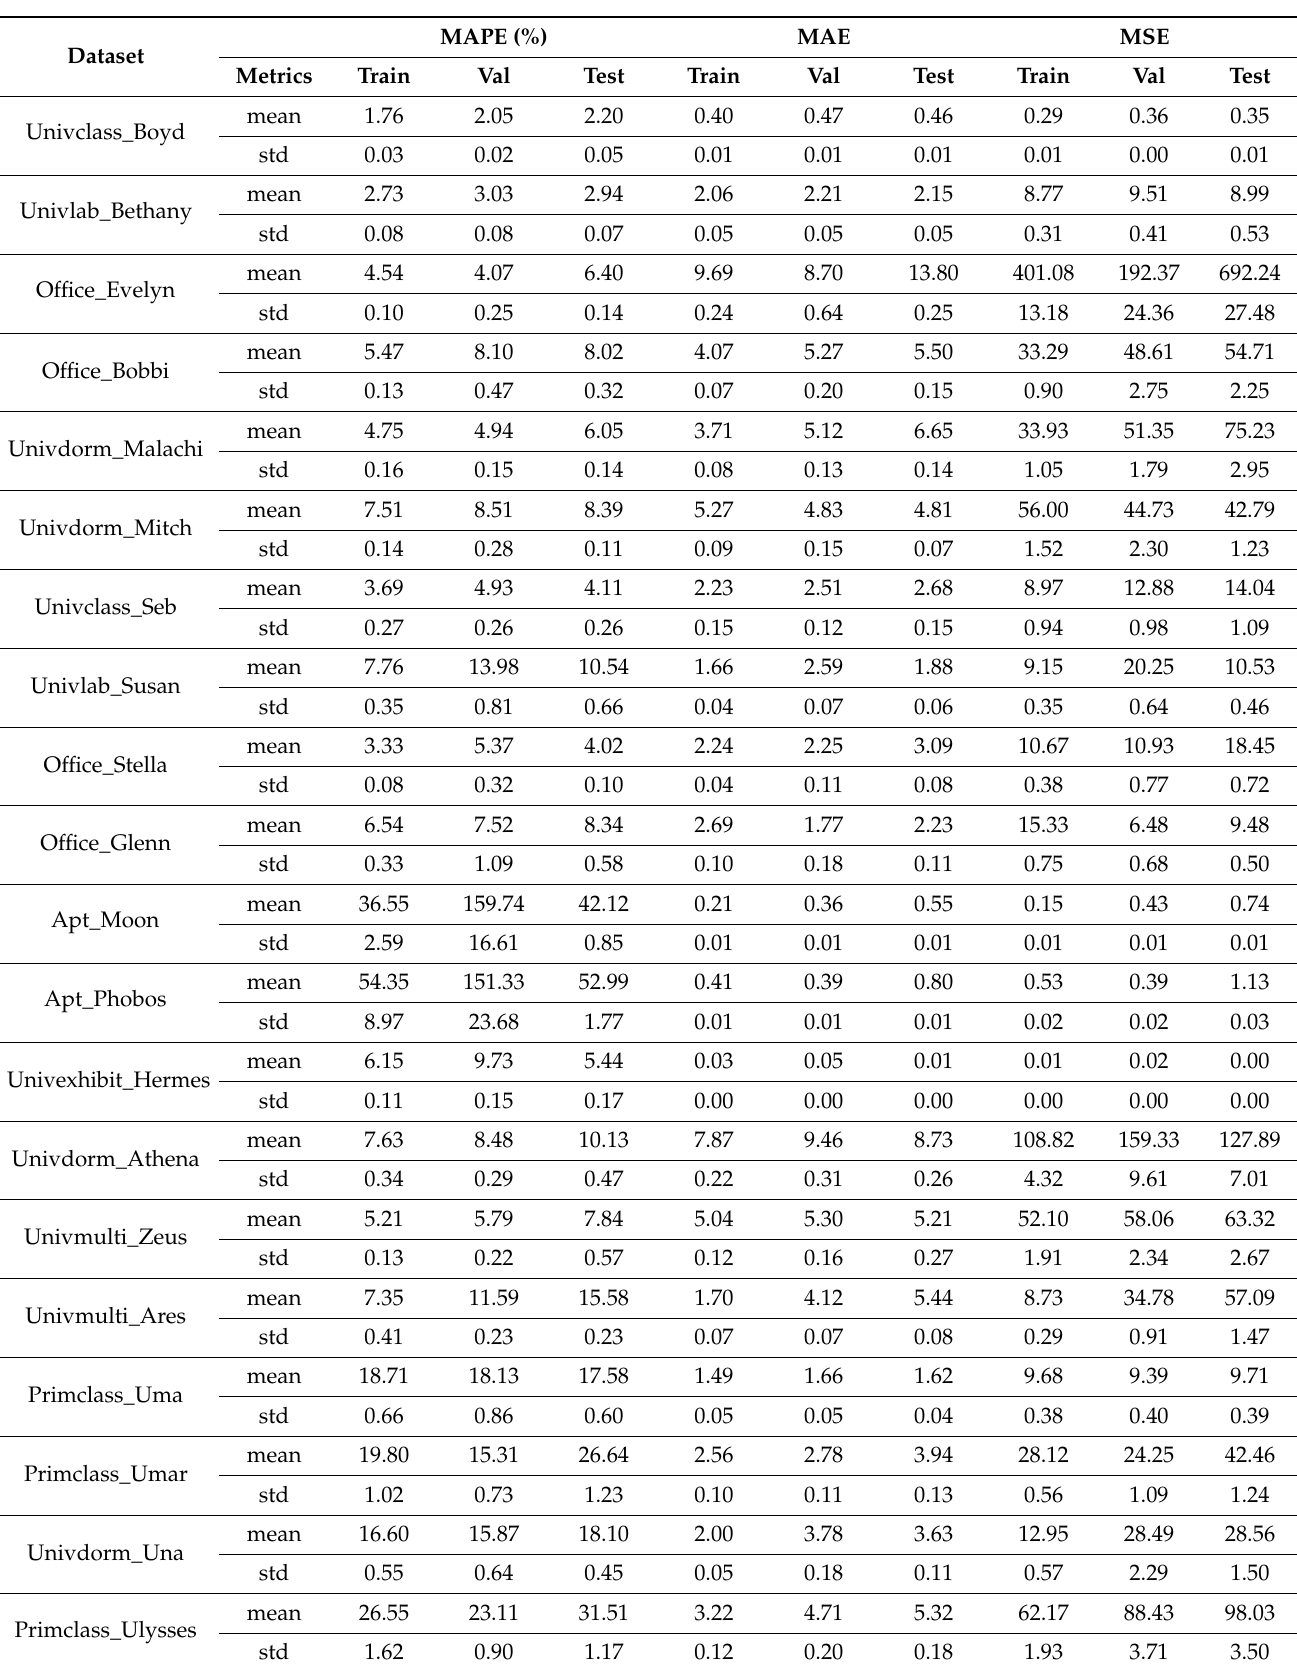
Table 8. The MAPE, MSE, and MAE of forecasting using RNN without